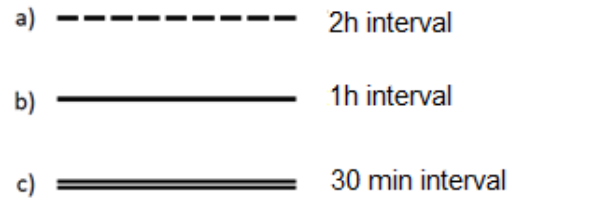
Figure 2. Line style usage convention according to the service